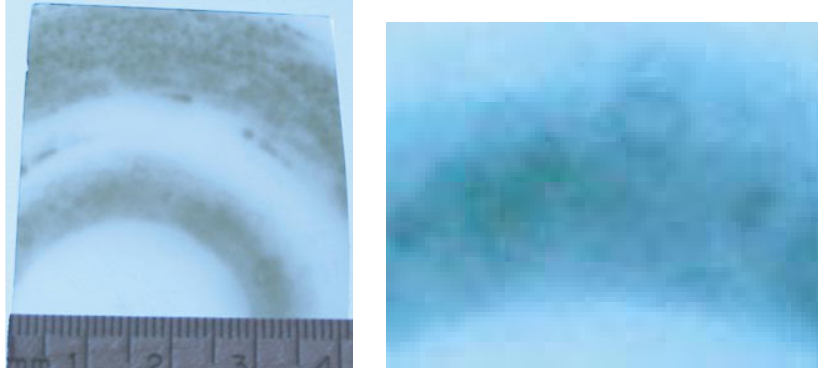
FIG. 17. (Color) The bands and beamlets in